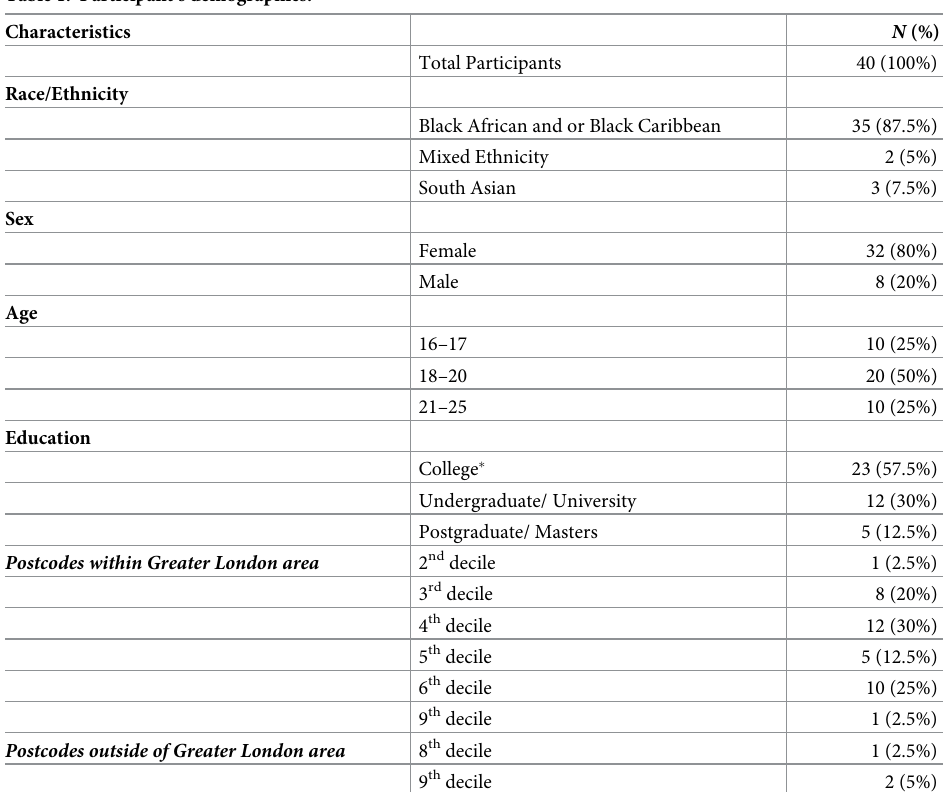
Table 1. Participant’s